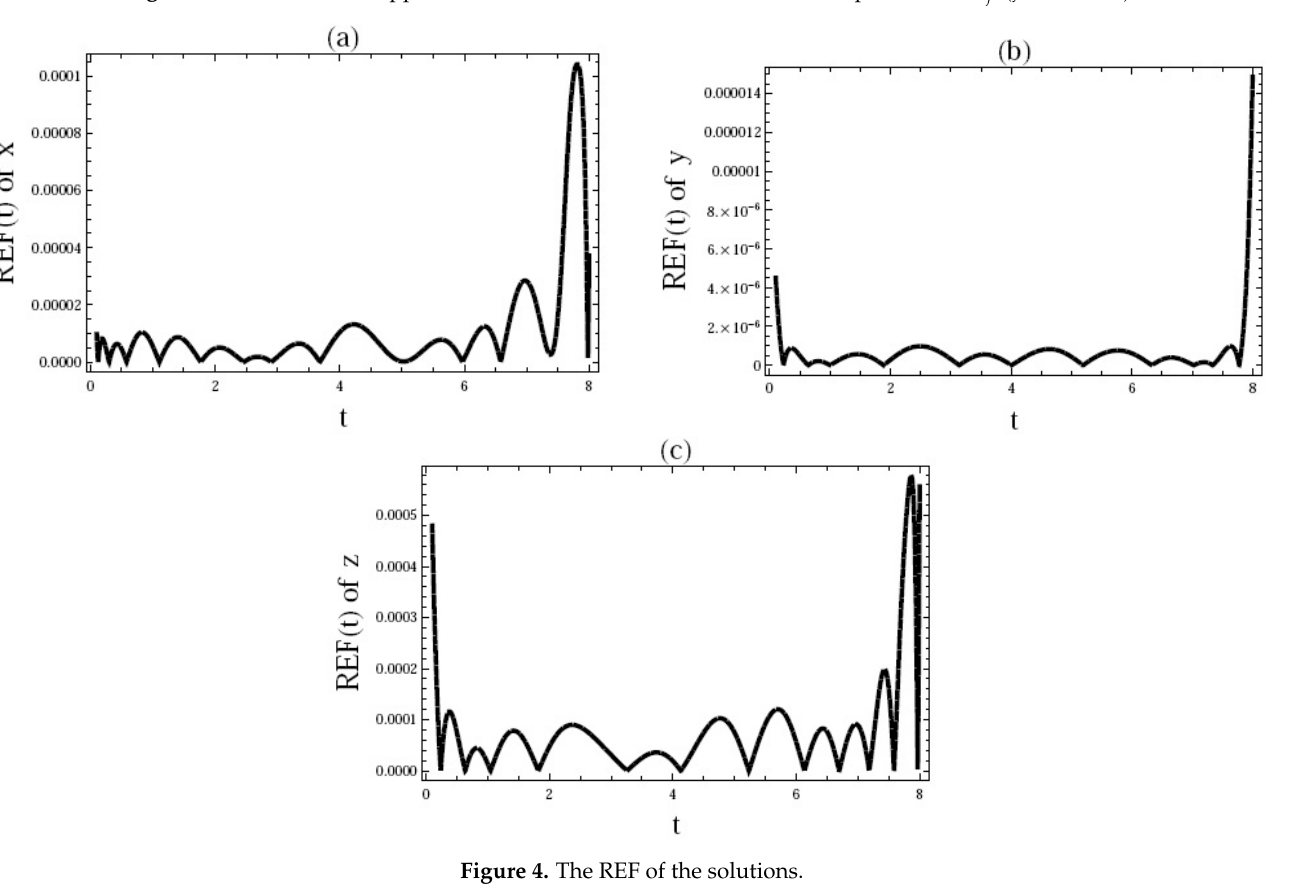
Figure 3. Behavior of the approximate solution via different values of the parameters λ j ( j = 1, . . . ,7 ) .